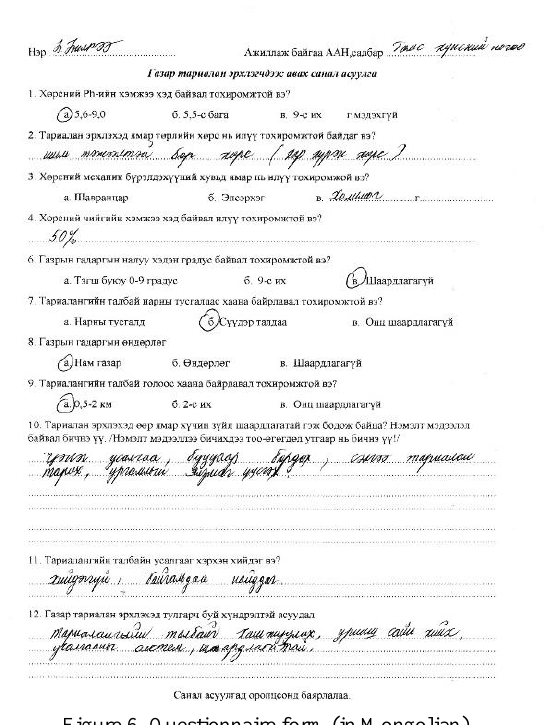
Figure 6. Questionnaire form (in